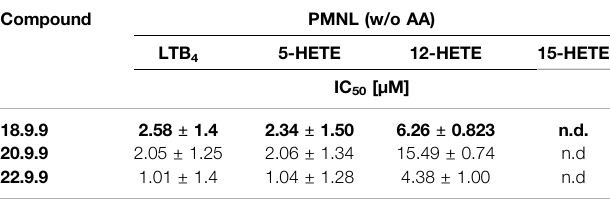
TABLE4| IC 50 valuesofinhibitoryeffectsonLTB 4 andeicosanoid-producingLOs after NFA treatment of intact PMNL in absence of AA. Data are the mean of at least three independent experiments, n (cid:2) 3. LO product formation in absence of AA(5 × 10 6 cells)was106.2 ± 48.7 ng/ml(LTB 4 ),80.9 ± 10.7